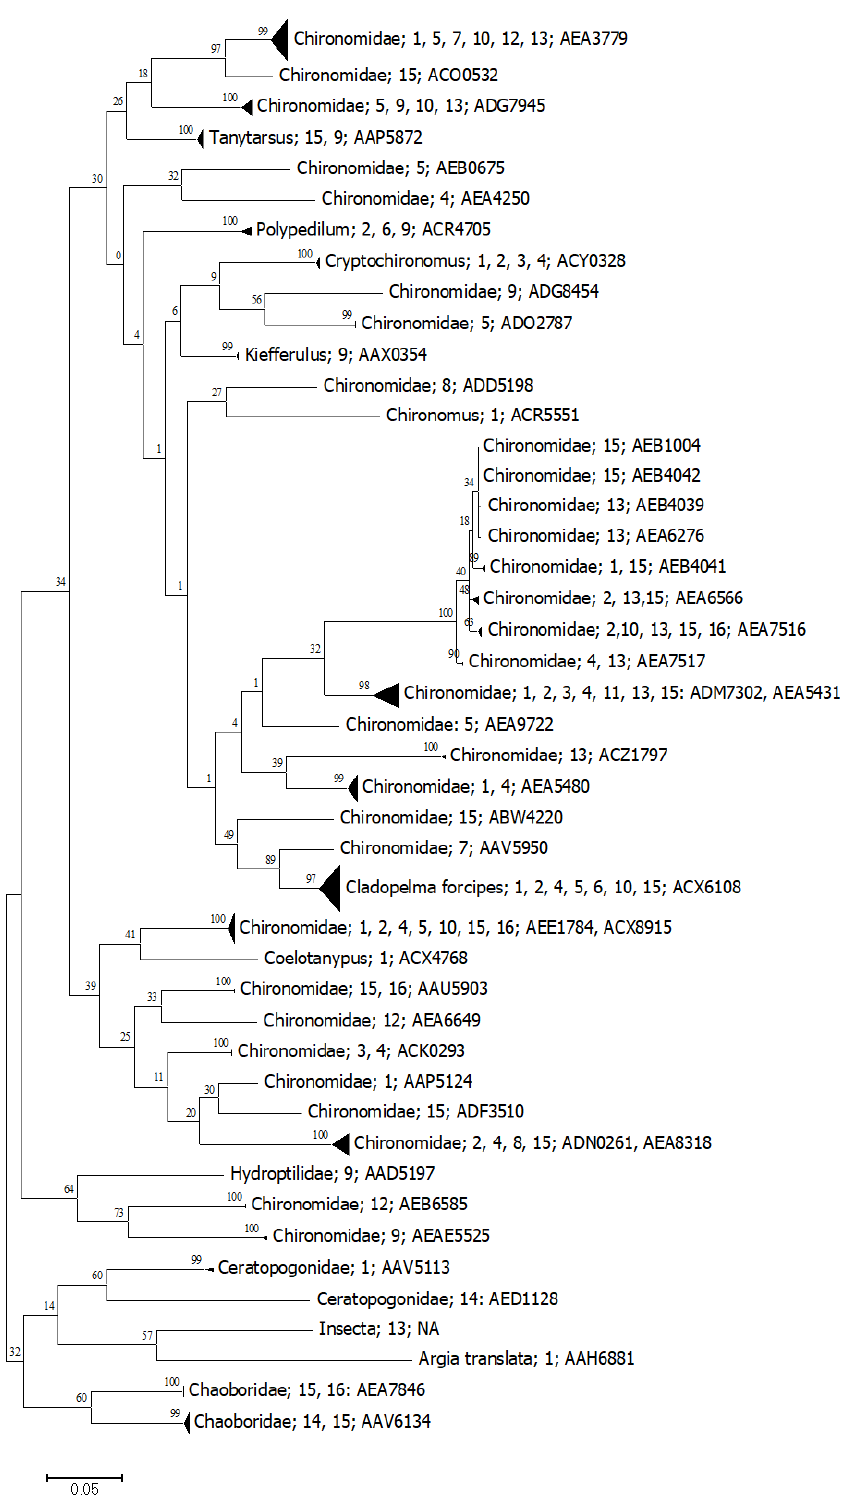
Figure 5. Simplified tree for Insecta. Numbers represent the aquatic system as presented in Table 1. The last number corresponds to the BIN assigned in BOLD. Bootstrap support is shown in each branch.